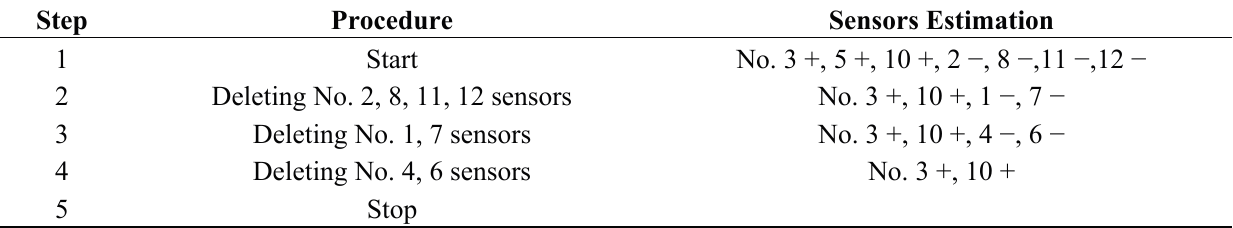
Table 3. Sensor grading